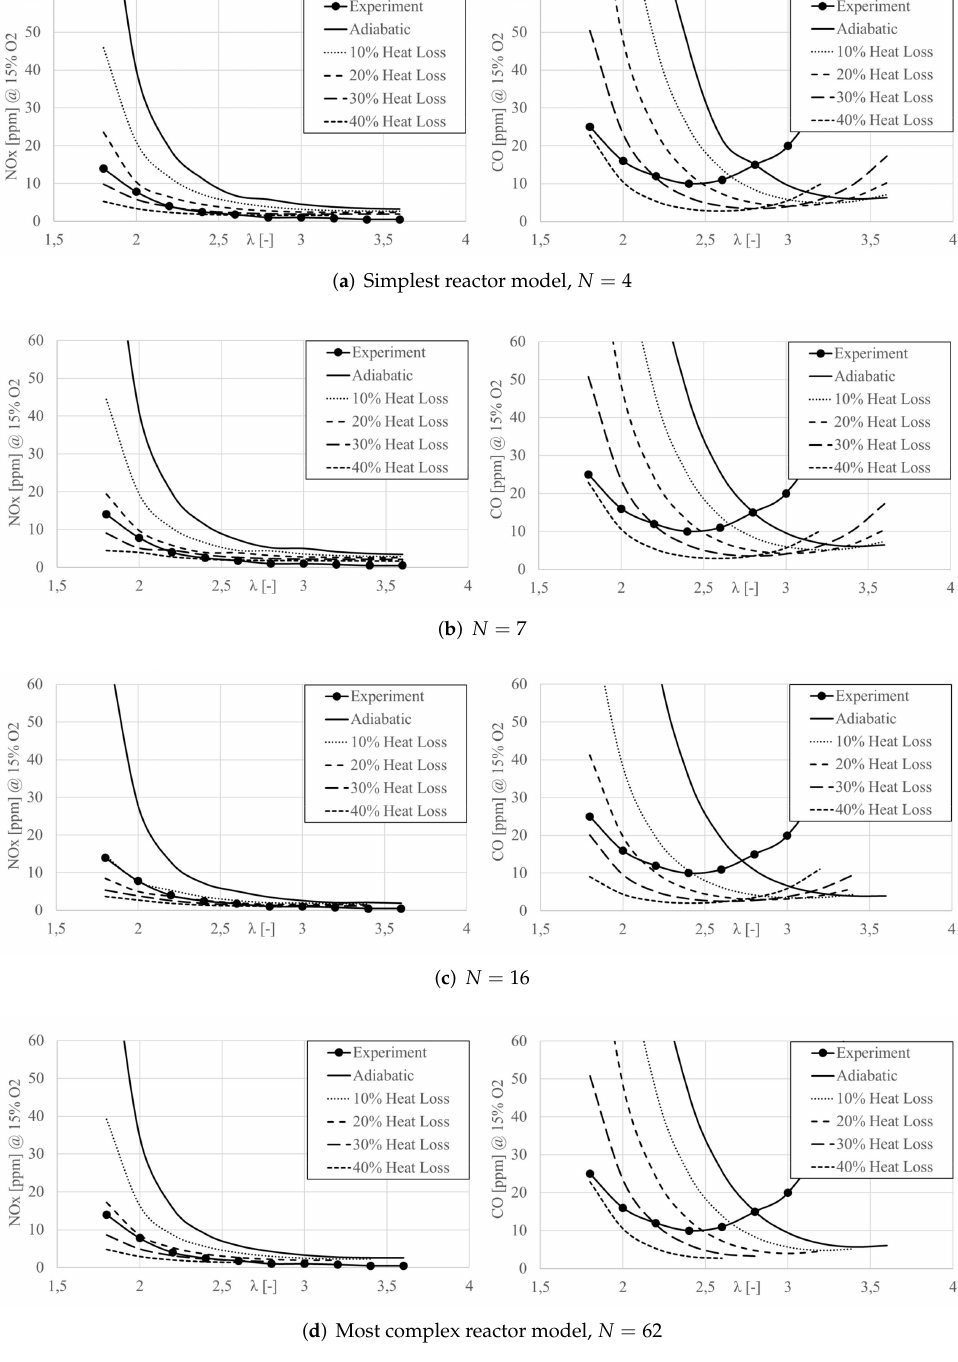
Figure 13. NOx and CO emissions at 15 % oxygen, evaluated for the reactor network models. N : number of PSR reactors. Variation of system heat loss in sensible ranges for atmospheric testing [49] with respect to overall fuel energy